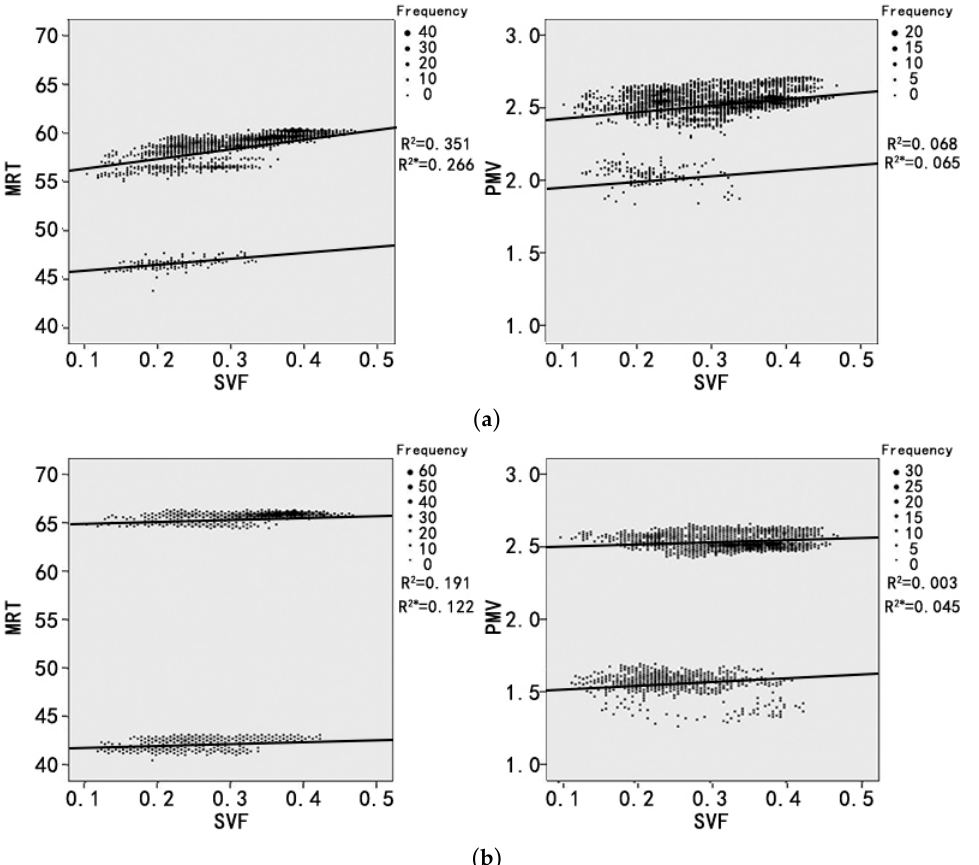
Figure 10. Correlation between SVF and MRT/PMV for LCZ2 at 12:00 in ( a ) Nanjing and ( b ) Germany, with indication of the square of the correlation coefficient R 2 . Please note that R 2 refers to the direct-radiation area and R 2 * to the shadow area.